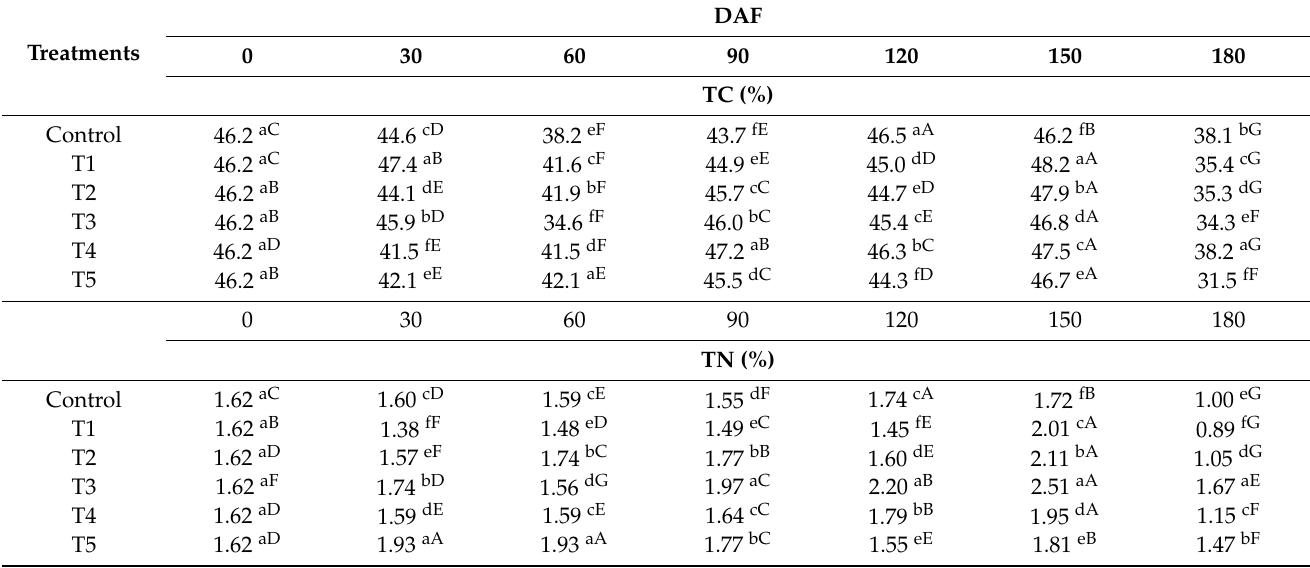
Table 5. Total carbon (TC) and total nitrogen (TN) and of leaf samples of cocoa plants under different fertilization rate of 0–6